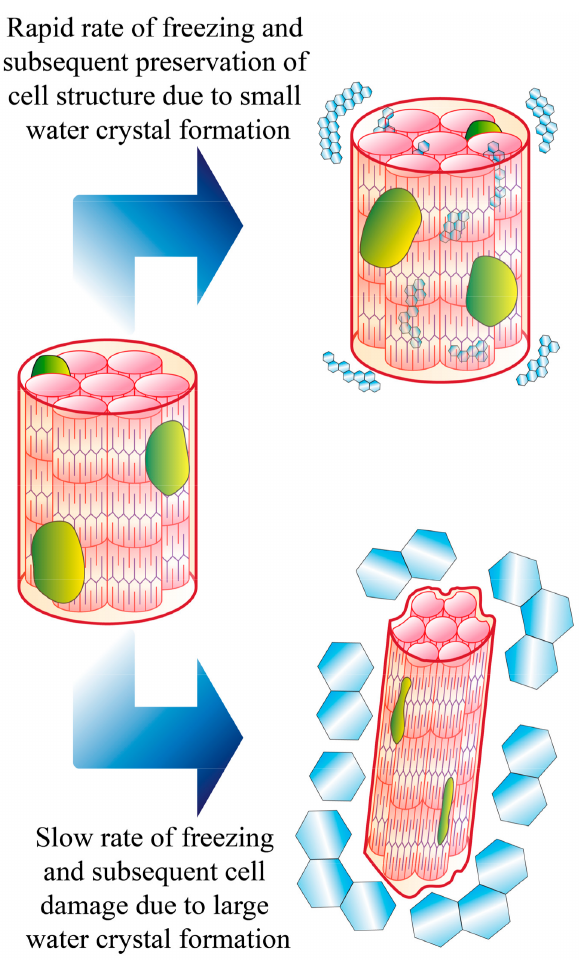
Figure 4. Effects of cell integrity at different speeds of cooling and water crystallization. Adapted from Schudel, et al.